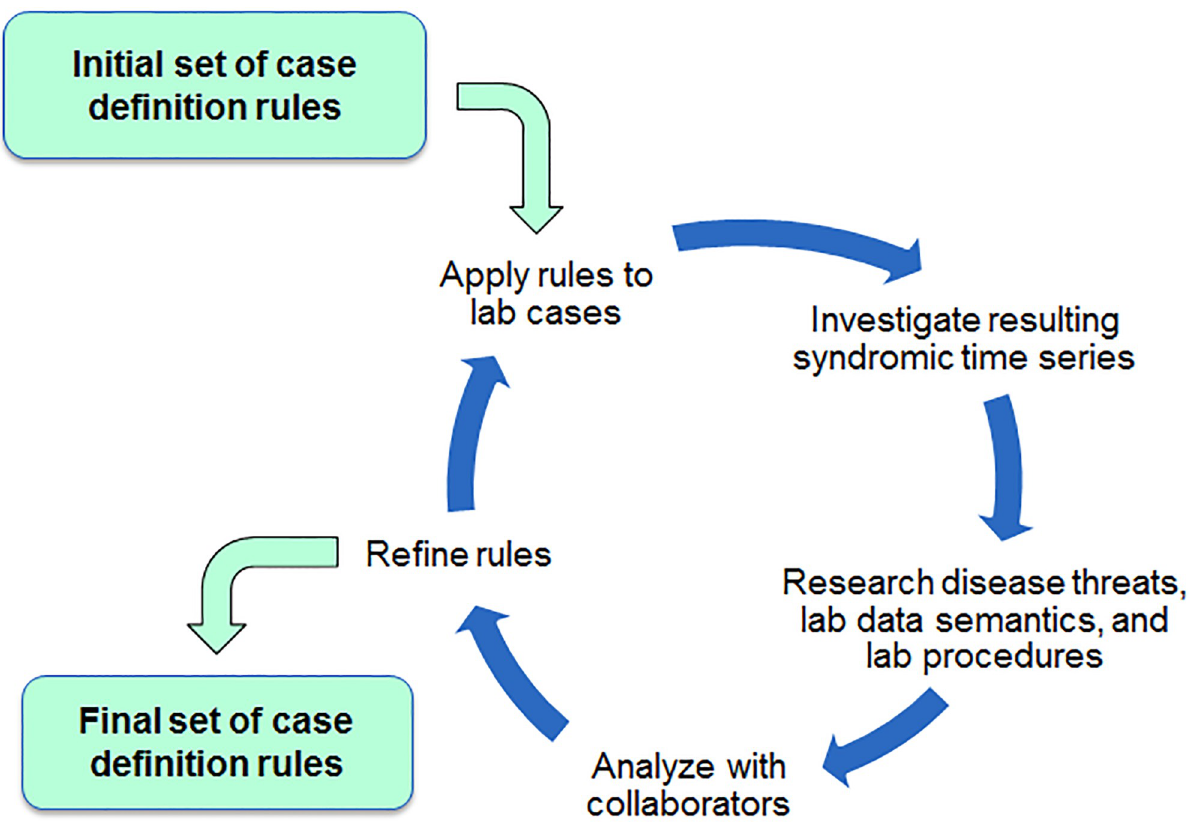
Fig 2. Schematic depicting the case definition refinement